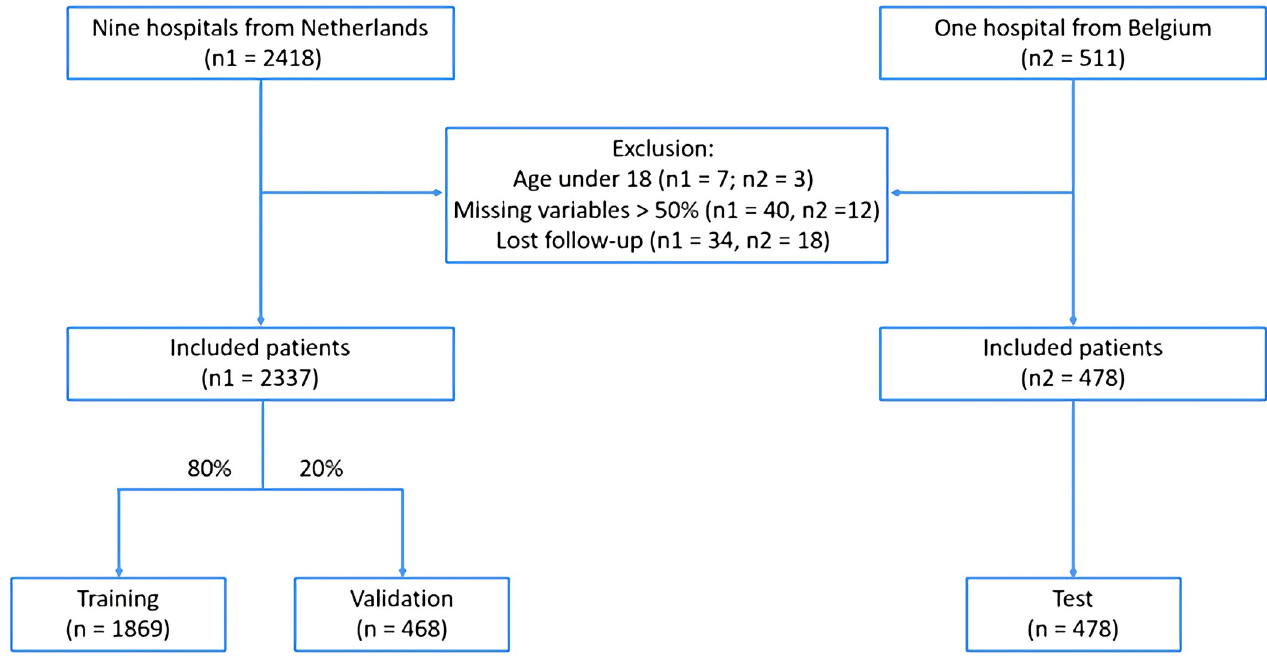
Fig 1. Flowchart of patient